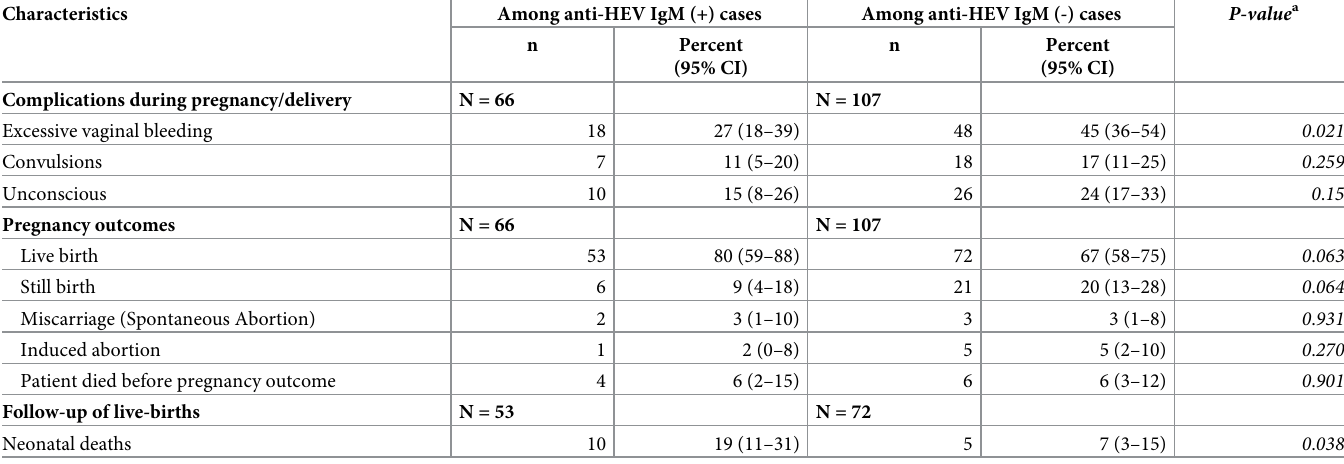
Table 4. Reported complications during pregnancy, pregnancy outcomes and survival status of newborn babies by anti-HEV IgM test status of mother in six ter- tiary hospitals in Bangladesh, December 2014–September 2017.